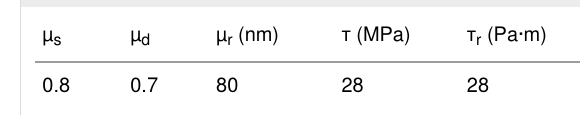
Table 1: AFM properties of the cylindrical gold nanoparticle modeled in this study [7].